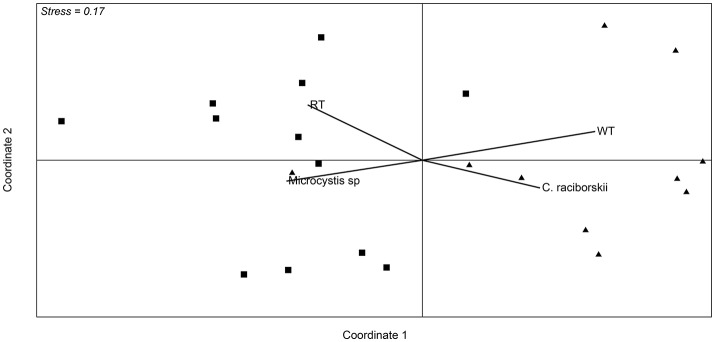
Non-metric multidimensional scaling ordination based on Bray-Curtis similarity of data from OTU abundance in the samples from the two sampling points. Squares correspond to samples from October 2013 to mid January 2014, and triangles correspond to samples from the end of January 2014 to March. Vectors are environmental variables and cyanobacterial microscopic counts that were significantly different between the two defined periods (p < 0.01). RT (retention time) WT (water transparency).